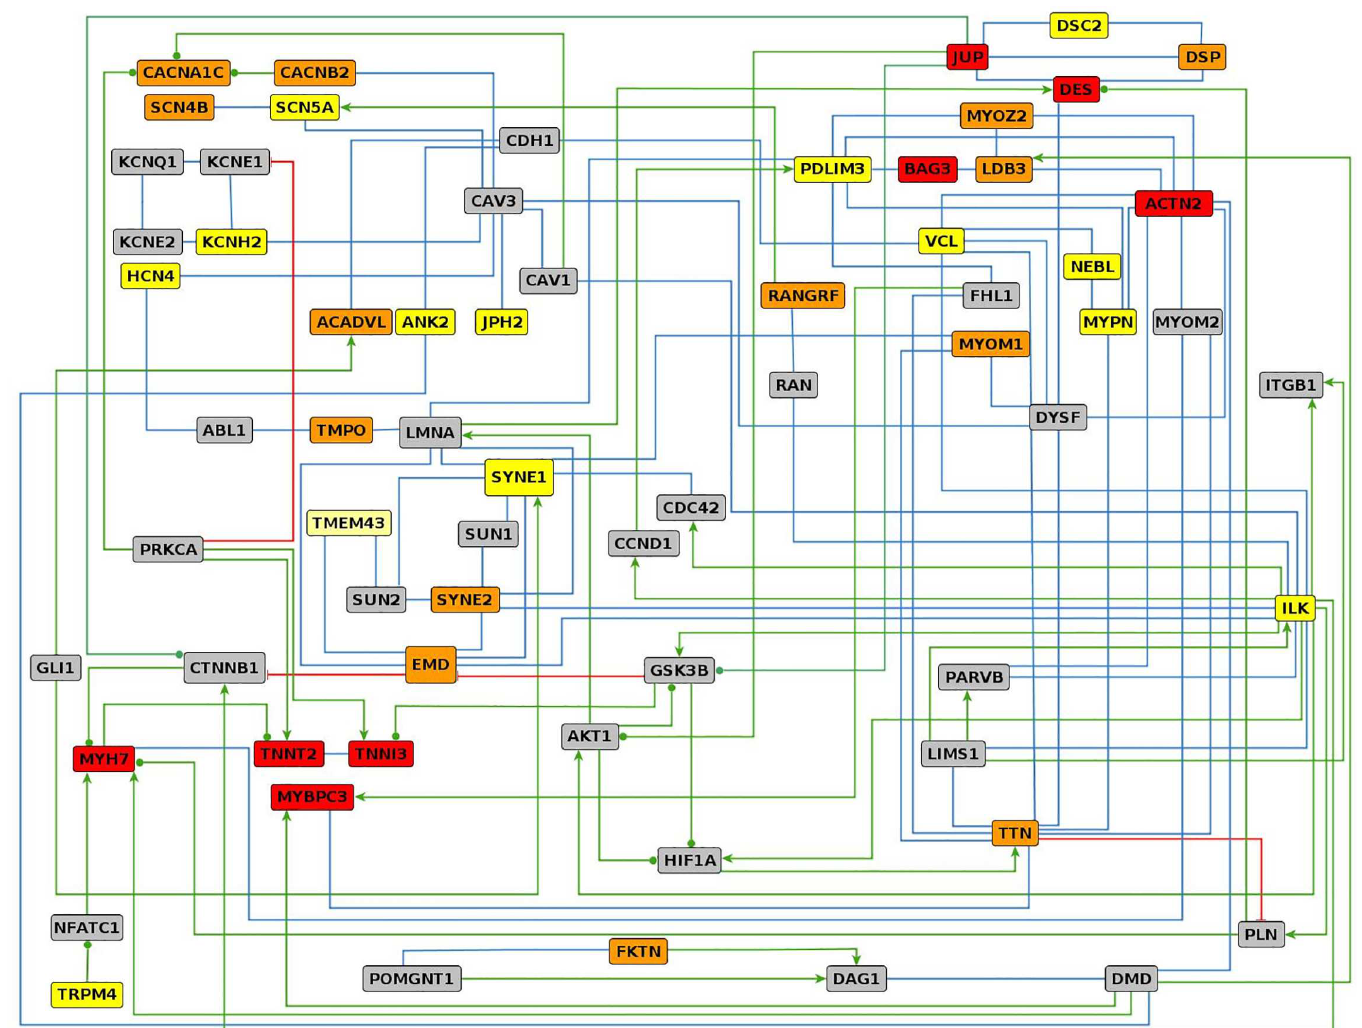
Fig 2. Interaction network of proteins harboring RCM-associated genetic variants. For proteins with RCM-associated pathogenic and likely pathogenicvariants (red boxed), variants of unknownsignificance (orange boxes) and rare SNPs (yellow boxes) a closely interconnected network was generated by manual curation of scientific literature. The interlinkingproteins are shown as gray boxes. Green arrows, red lines with cross bars, green lines with filled circles, and blue lines indicate activation, inhibition,modulation of activity, and direct physical interactions,